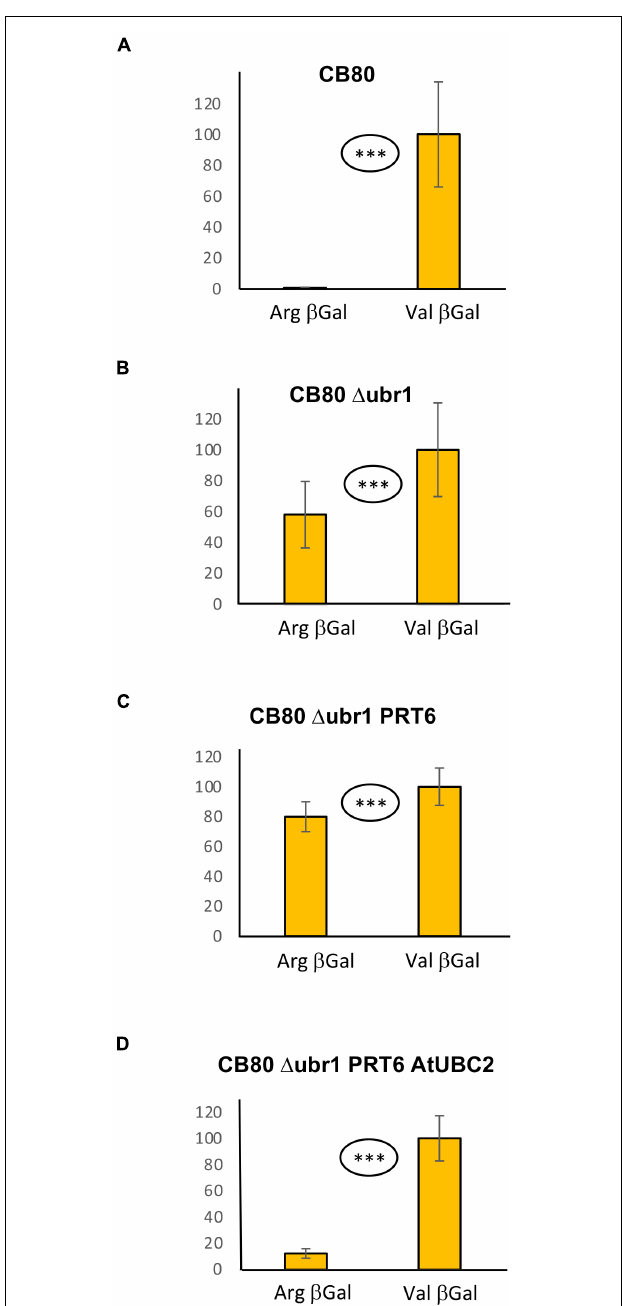
FIGURE 1 | Steady-state levels of β Gal-based model substrates starting either with Arg or with Val in different yeast strains (A–D) . Values of Val β Gal were set 100%. Differences between columns are significant ( ∗∗∗ p < 0.001, two-sided t test). At least eight replicates were used for each colummn. Numerical values are listed in Supplementary File 6